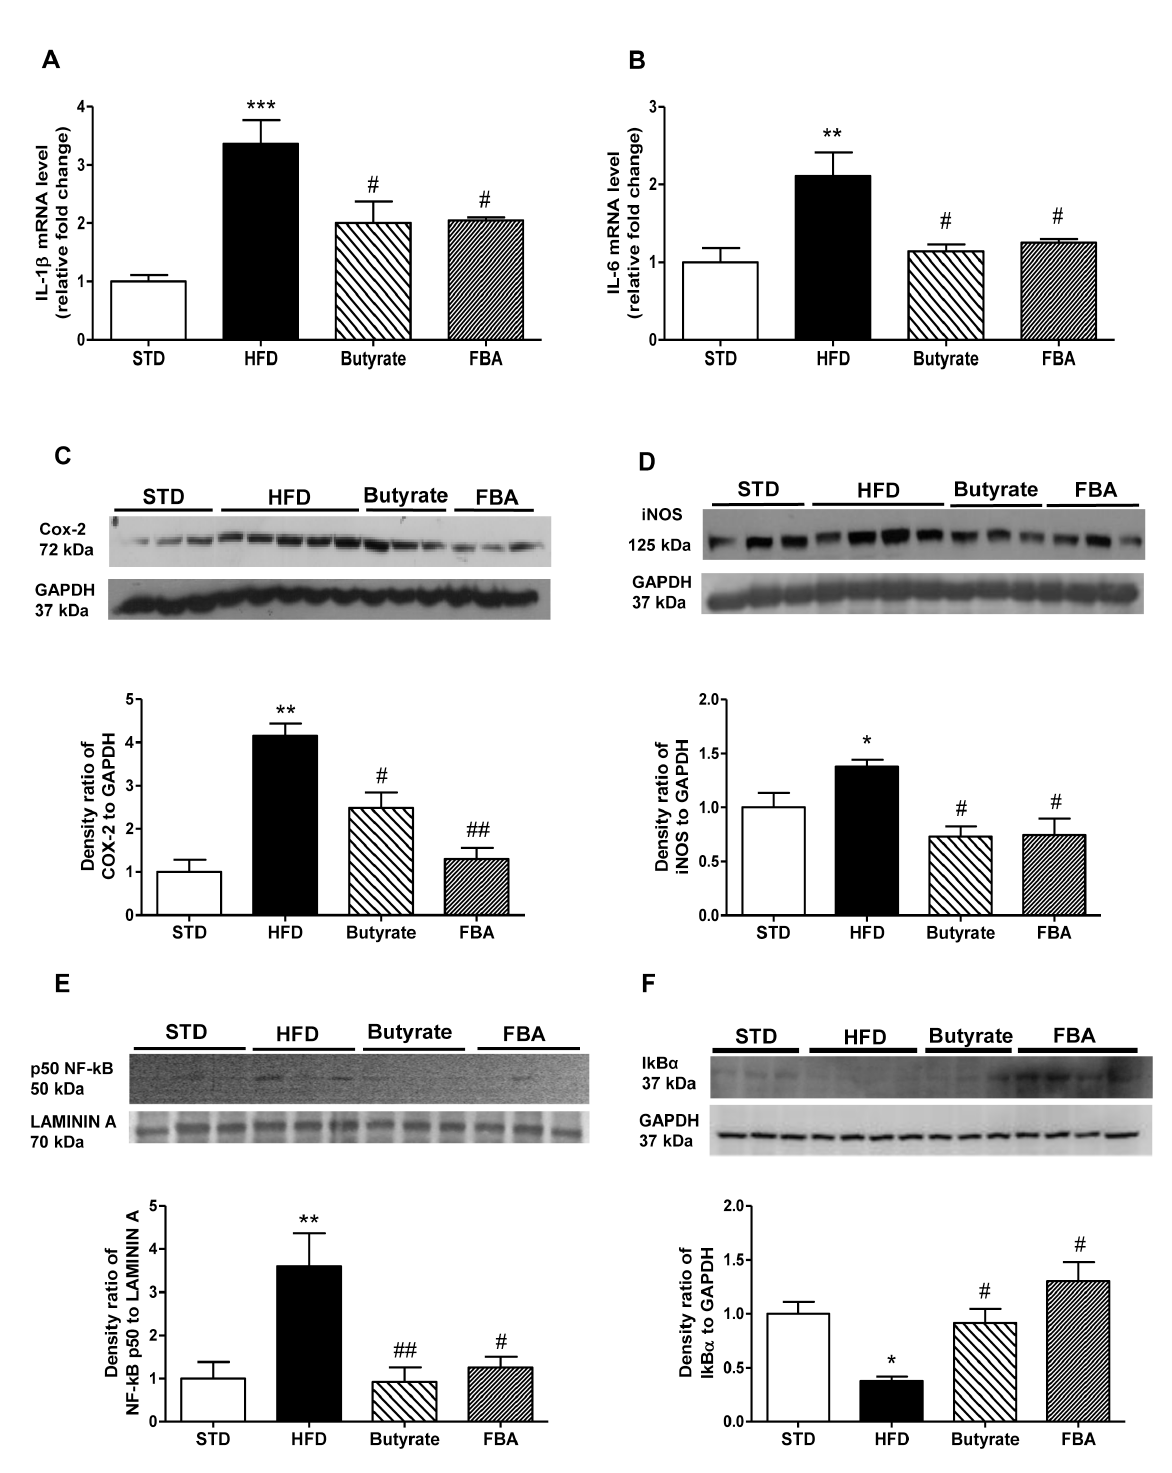
Figure 2. Modulation of hepatic inflammatory parameters and NF-κB activation by butyrate and FBA. IL-1β (A) and IL-6 (B) mRNA expression (relative fold change to STD) are reported (n=6, each group). Panels C and D show representative Western blot analysis of pro-inflammatory enzymes COX-2 and iNOS, respectively, in the liver extracts. Nuclear p50 NF-κB (E), and cytosolic inhibitory protein IκB-α (F) expression is reported (n=6 each group). *P<0.05, **P<0.01, ***P<0.001 vs STD; # P<0.05, # # P<0.01 vs HFD.